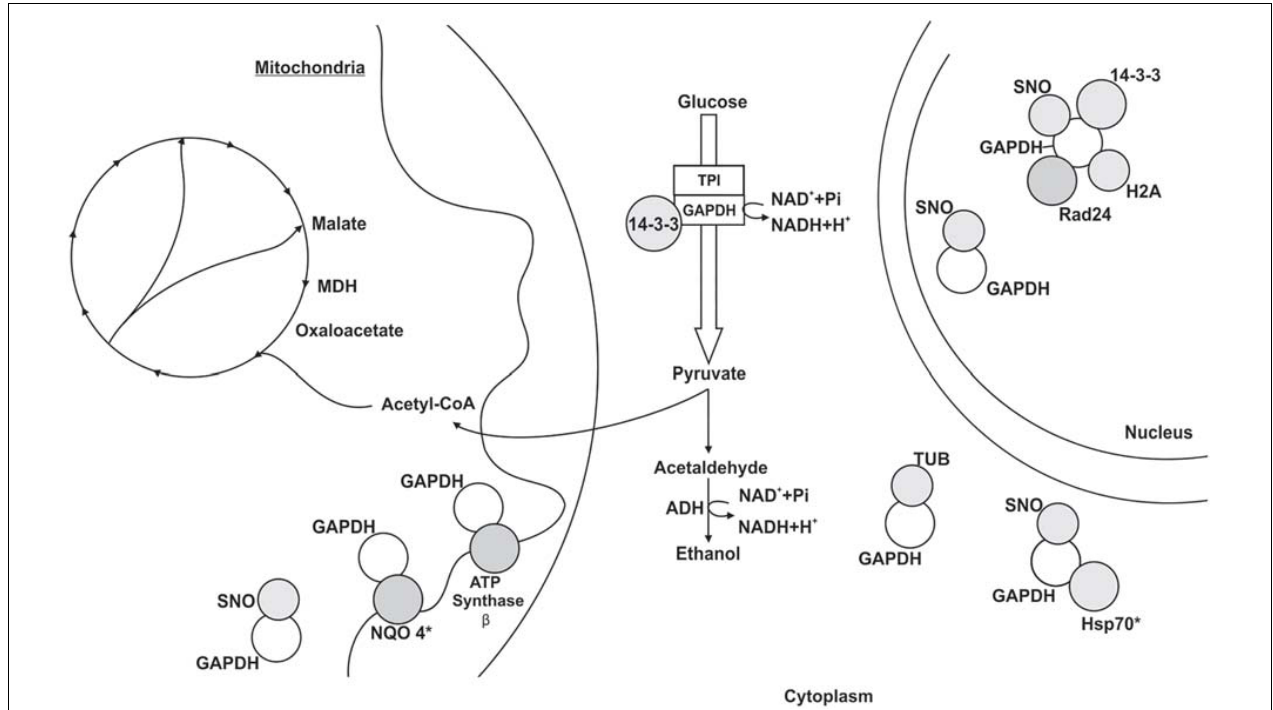
FIGURE 4 | Schematic model of the metabolic processes involving GAPDH through PPIs in P. lutzii mycelium-to-yeast transition. All proteins shown in the figures interacted with GAPDH. GAPDH (glyceraldehyde-3-phosphate dehydrogenase), SNO (nitrosylation), MDH (malate dehydrogenase), TPI (triosephosphate isomerase), NQO4 (NAD(P)H:quinone oxidoreductase type IV), tubulin α -1 chain (TUB), HSP70 (heat shock protein 70), histone H2A (H2A) and ADH (alcohol dehydrogenase). The figure also shows the proteins 14-3-3, Rad24 and ATP synthase β . Asterisks indicate proteins identified as GAPDH partners by both the chromatographic and BN-PAGE